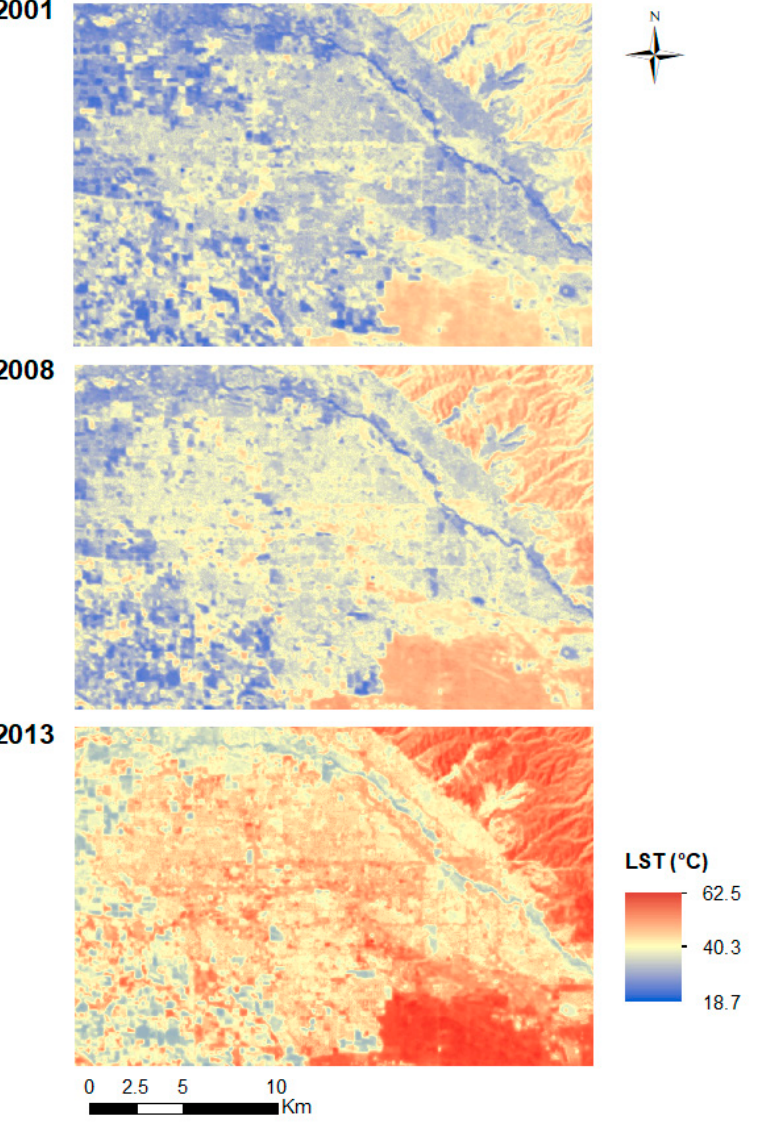
Figure 3. Land surface temperature (LST) maps of the Boise-Meridian metropolitan area in 2001, 2008, and 2013.